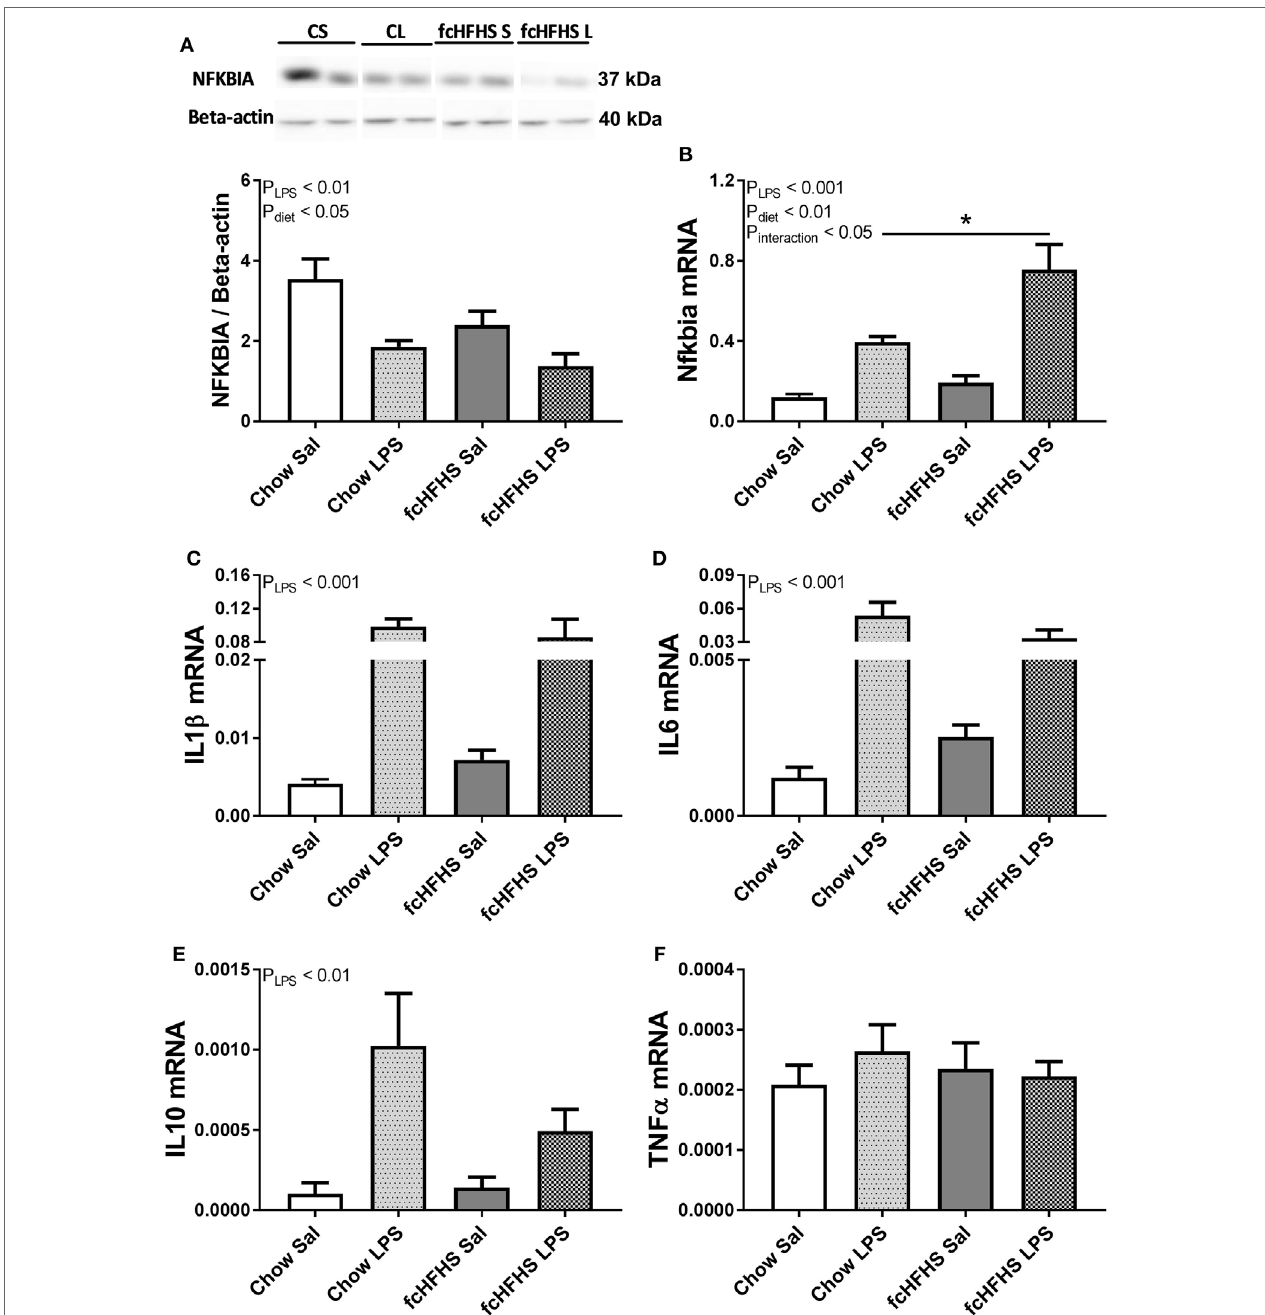
FigUre 1 | One-week free-choice high-fat high-sugar (fcHFHS) diet and 2 h lipopolysaccharide (LPS) independently reduced hypothalamic (a) NFKBIA protein levels and increased (b) relative Nfkbia mRNA expression in rats. Blots of NFKBIA (Figure S1 in Supplementary Material) and Beta-actin (Figure S2 in Supplementary Material) in (a) include two bands per group (CS, chow saline; CL, chow LPS; fcHFHS S, fcHFHS saline; fcHFHS L, fcHFHS LPS) that represents significant effects seen in eight animals per group. (c) Relative Il1 β , (D) Il6 , and (e) Il10 mRNA expression was increased only upon LPS, whereas (F) relative Tnf α mRNA expression did not change. Statistical analysis was performed using two-way ANOVA followed by post hoc analysis in case of a significant interaction effect. Specific gene expression was normalized to the geometric mean of three housekeeping genes; ( Hprt * Actb * Ppia ) 1/3 . Data are presented as mean ( n = 8) ± SEM; * p <